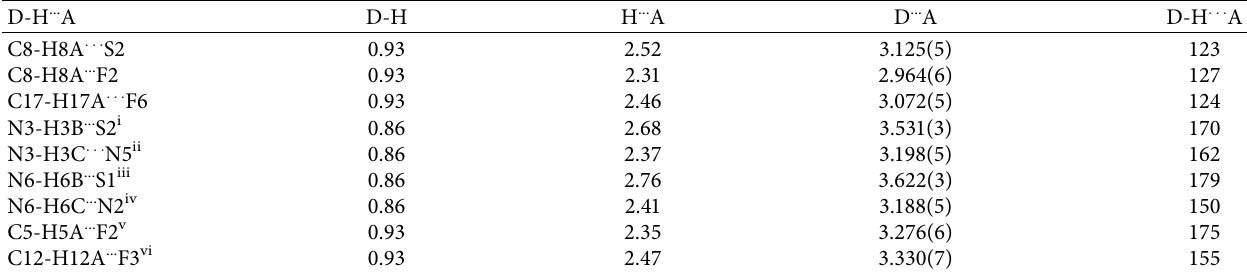
Table 3: Hydrogen bonds for NiL